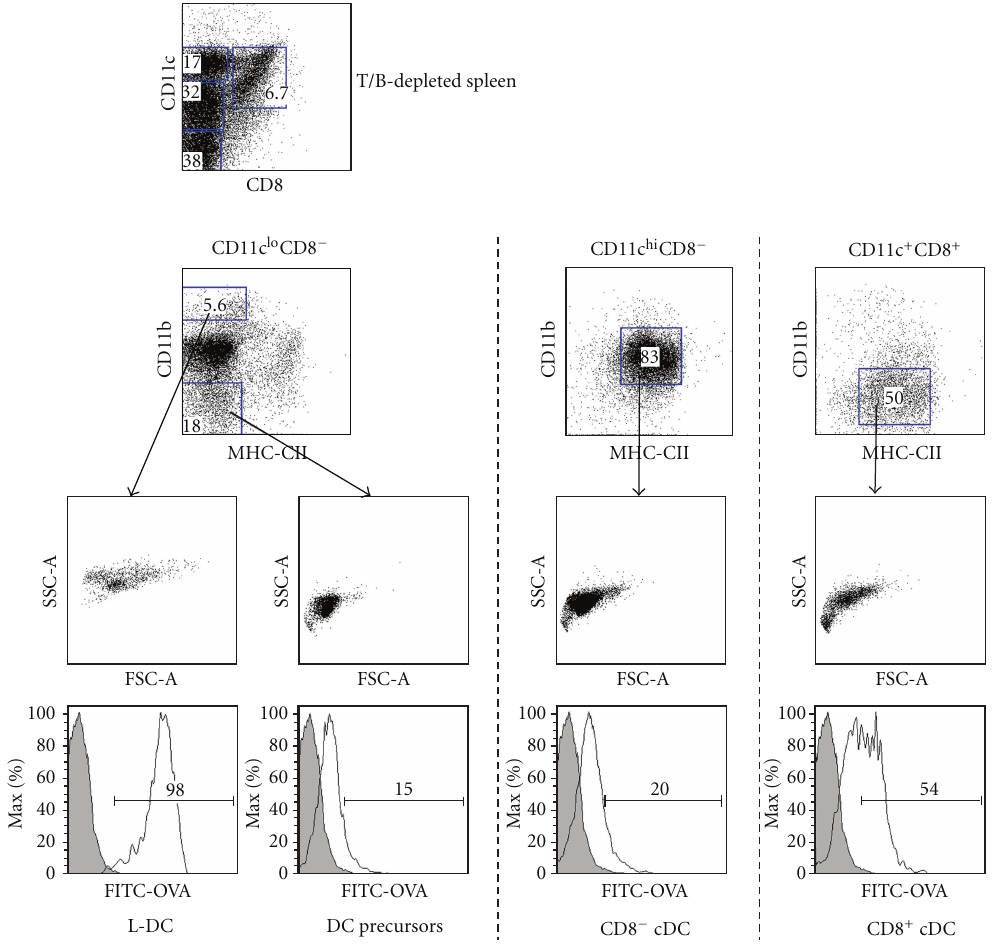
Figure 3: Isolation of L-DC (LIVE-DC) in spleen amongst other DC subsets. Spleens were depleted of T and B cells using antibody-coated magnetic beads and then stained with antibodies specific for CD11c, CD11b, CD8 α and MHC-II ahead of flow cytometric analysis. DC subsets were identified based on multiple parameters of forward scatter (FSC), side scatter (SSC), marker expression and endocytosis after intravenous administration of FITC-OVA (0.6mg/mouse) 24 hours